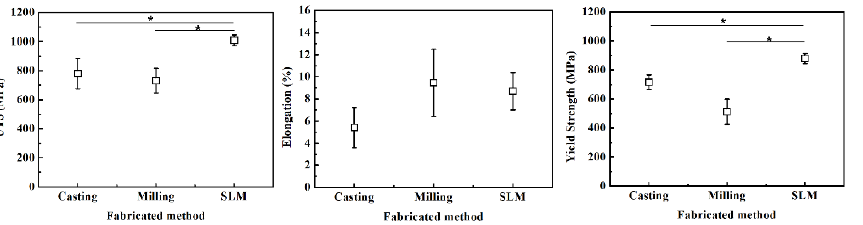
Figure 2. Ultimate tensile strength, elongation and yield strength following different manufacturing techniques. *, significant at p < 0.05.